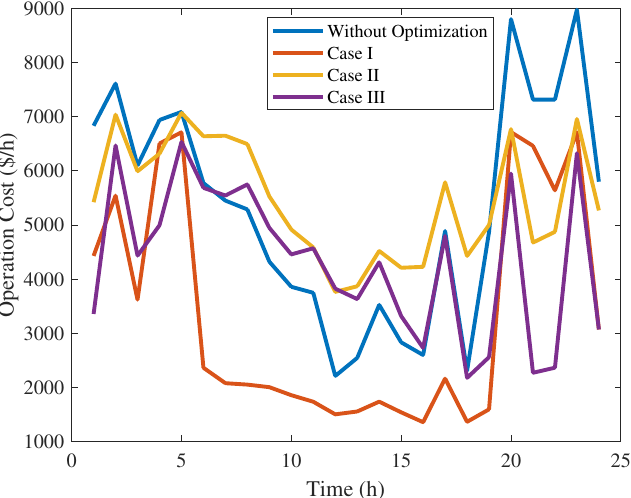
Figure 11. Comparison of operation cost of case studies and without optimization. Table 2. Total operation cost of generation